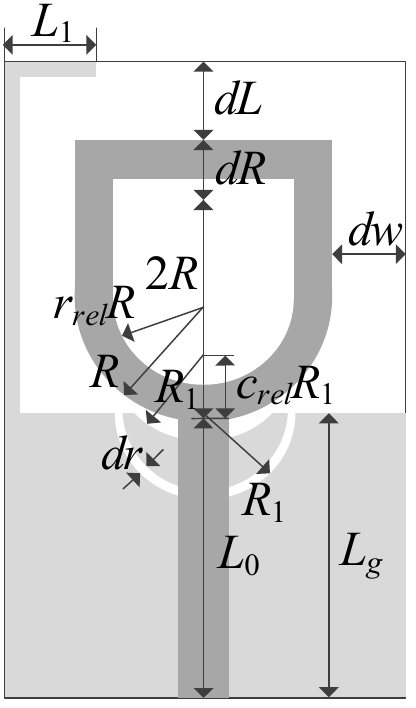
Figure 4. Geometry of Antenna I. The light gray shade is the ground plane on the backside of the structure.